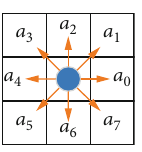
Figure 2: Illustration of UH movement